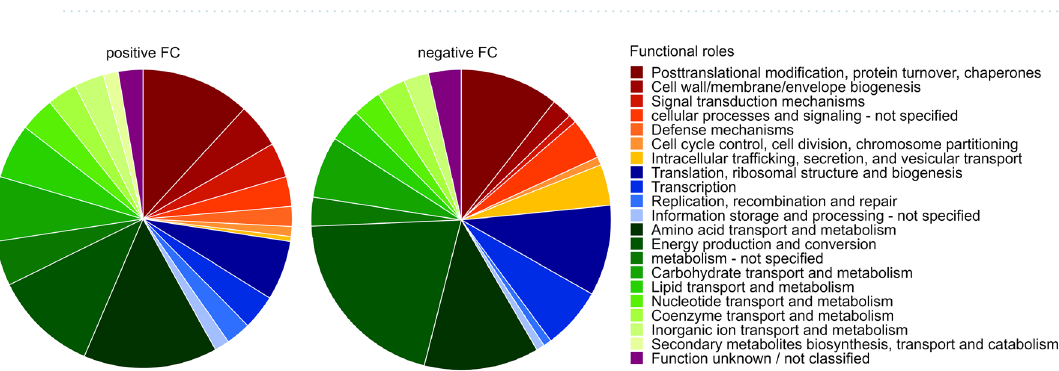
Figure 5. Volcano plot indicating differences in abundance of bacterial protein groups (PGs) between aphelid- infected (AI) and non-infected (NI) S. vauolatus cultures. PG fold changes (FCs) were calculated between AI and NI treatment after 4 days post inoculation (DPI) (light blue, left) and 7 DPI (dark blue, right) 56 . Log 2 fold change (Log 2 FC) are plotted against − log 10 transformed p -values to determine significantly ( p > 0.05) upregulated (FC > 1.5) and downregulated (FC < − 1.5) PGs.